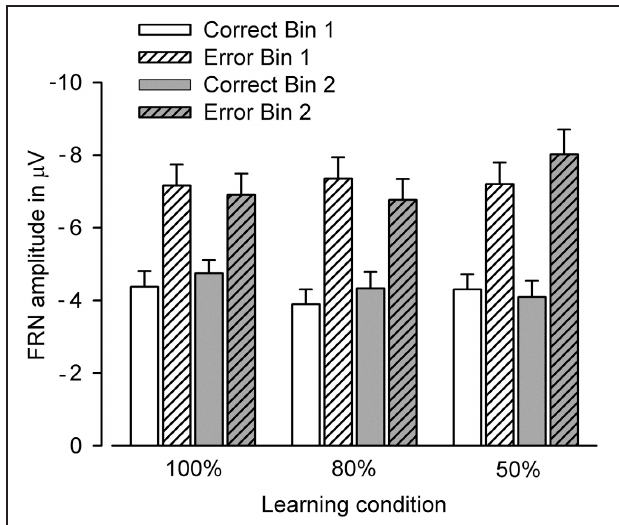
FIGURE 6 | Bar graphs show the amplitude of the FRN at FCz in Bin 1 and Bin 2 for “correct” and “incorrect” feedback.